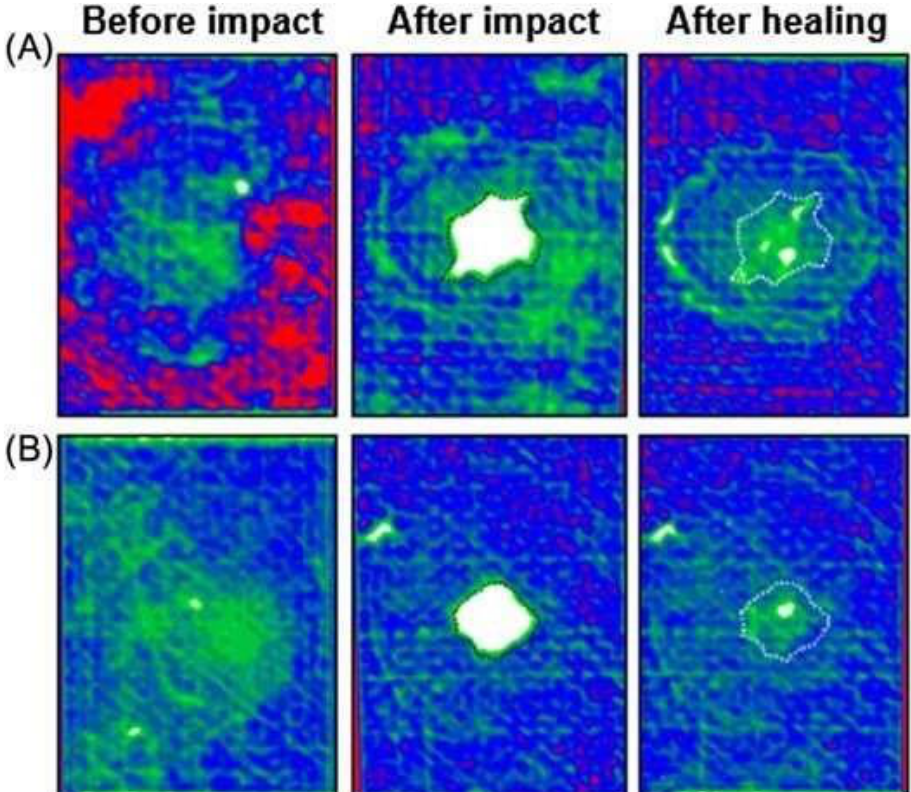
Figure 23. Damage induced due to impact before and after the test of ( A ) CFRP with nylon, ( B ) CFRP with MWCNT and nylon. The left side images show C-scans of the unaffected region before the test while the low velocity impact after the test can be seen in the images presented in the middle. The damage in specimens is due to delamination, as shown in the right side images of both ( A ) and ( B ) [206].